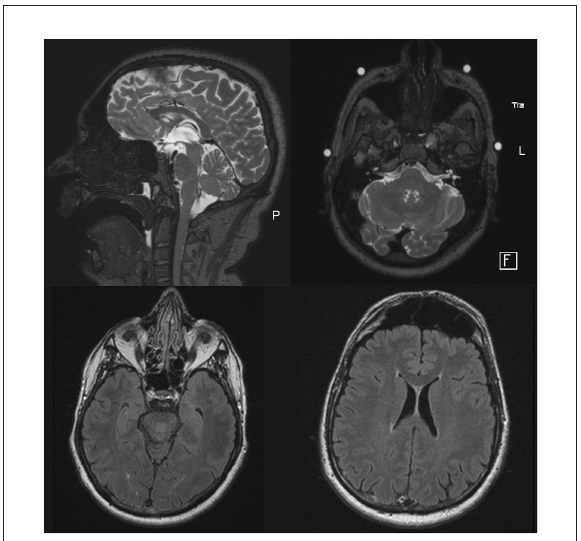
FIGURE1 MRI scan before DBS implantation. At age 47 years, MRI showed no signs of cerebellar or supratentorial atrophy. The middle cerebellar peduncles (MCP) were normally developed according to the patient’s age. The images presented in the sagittal and axial plane were acquired as T2-weighted